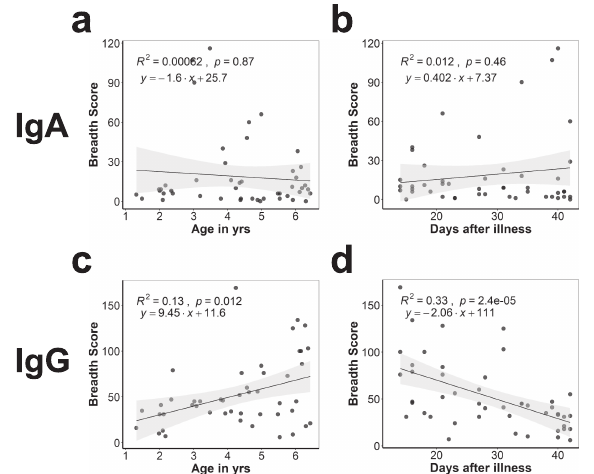
Fig. 6 IgG response to P. falciparum antigens correlate with age and time after infection in Malian children. Relationship between change in number of P. falciparum proteins recognized by IgA and IgG for each individual (breadth score) and age at the time of post- infection blood draw ( a , c ) and days after infection ( b , d ) for Malian children are